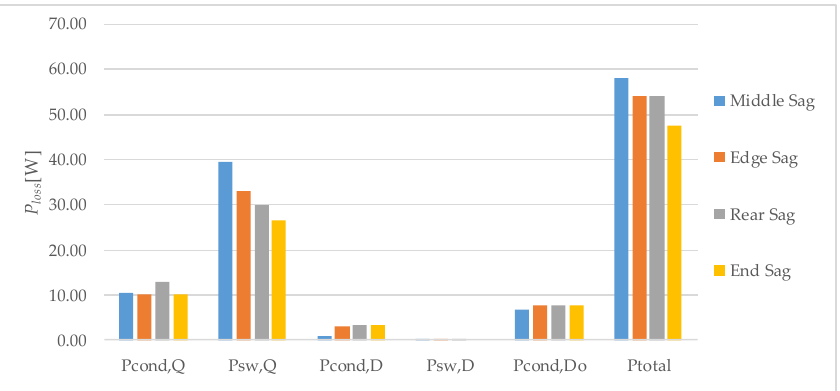
Figure 17. Switches loss analysis for the middle, edge, rear, and end sag types when P O = 1000 W.